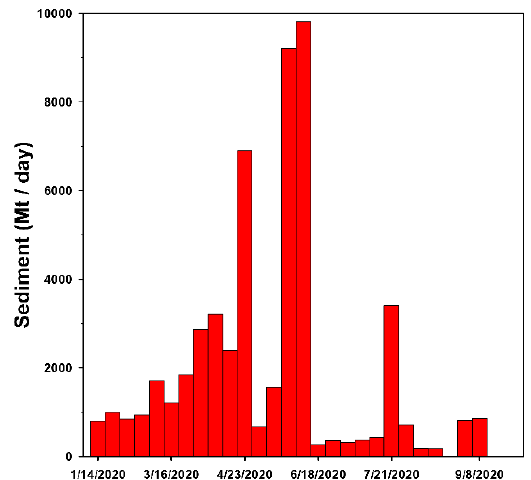
Figure 2. Measurements of daily sediment discharged from the Lanyang River estuary in 2020.